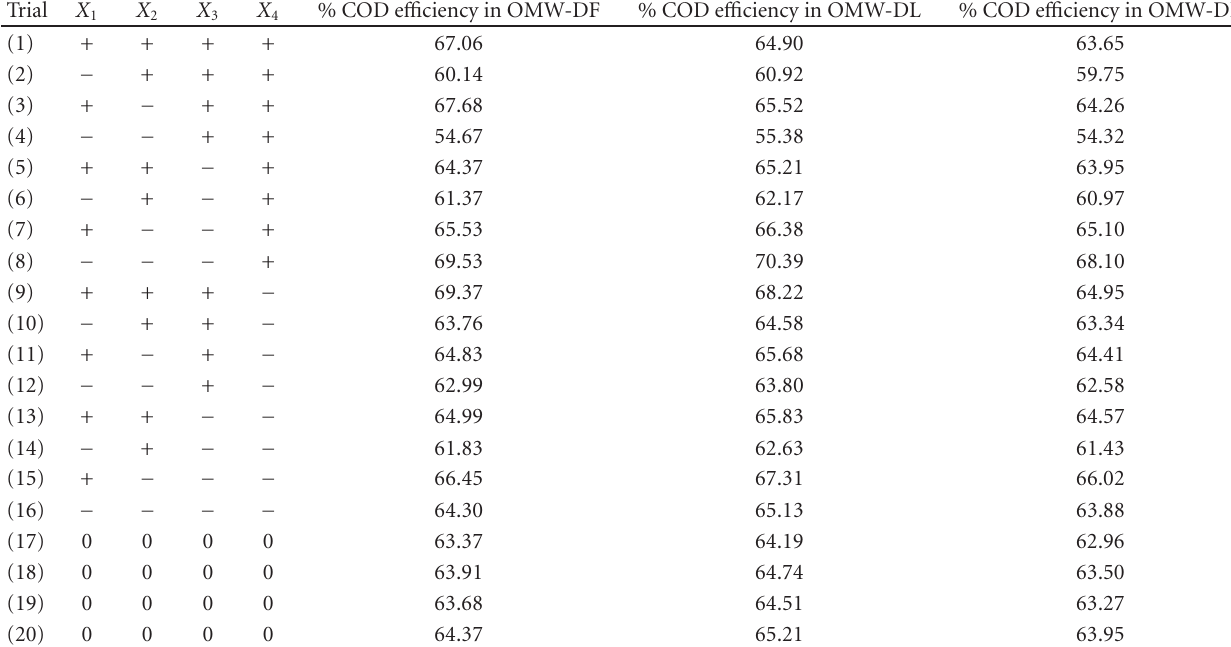
Table 4: Percent COD removal e ffi ciency results of the factorial